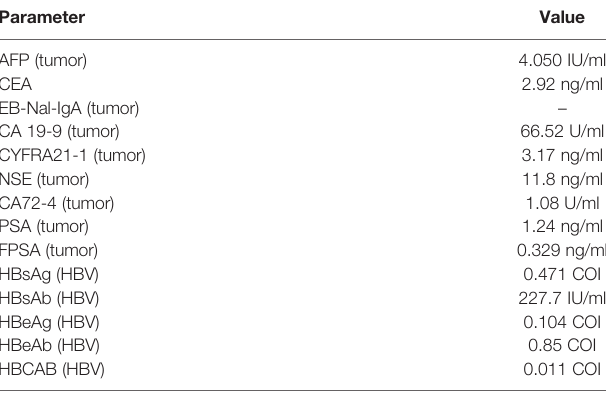
TABLE 2 | Laboratory values of immunity (Tumor and HBV) in April 2018. Parameter